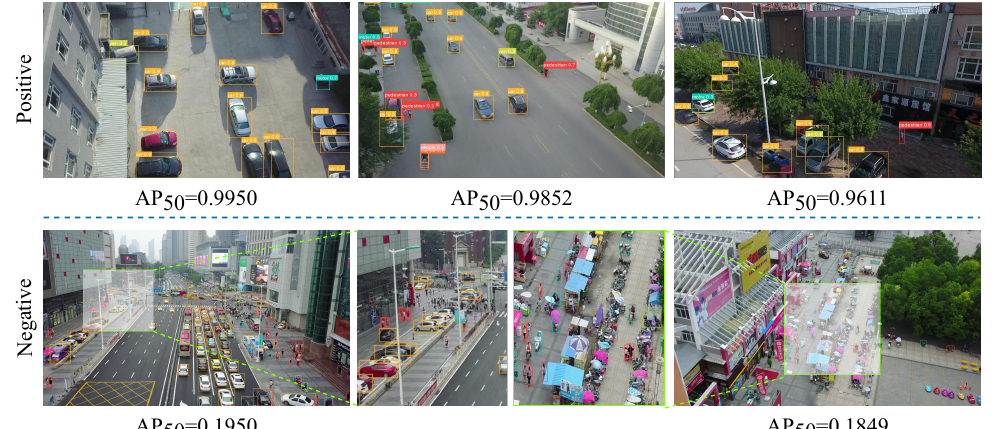
Figure 8. Examples of positive and negative image samples obtained by applying the baseline model. Positive image samples contain few, sparsely distributed, large sized objects in the first row. Negative image samples contain large number of objects, and crowded and small objects.